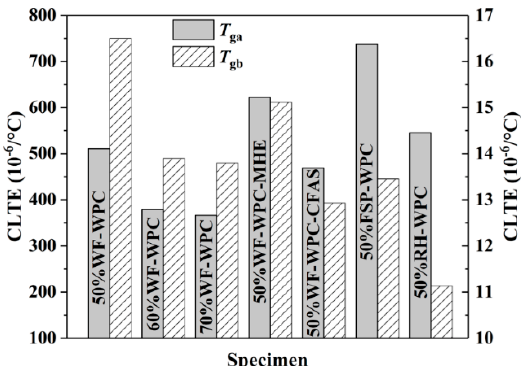
Figure 5. The coefficient of linear thermal expansion (CLTE) of WPCs above and below T g ( T ga —above T g ; T gb —below T g ).